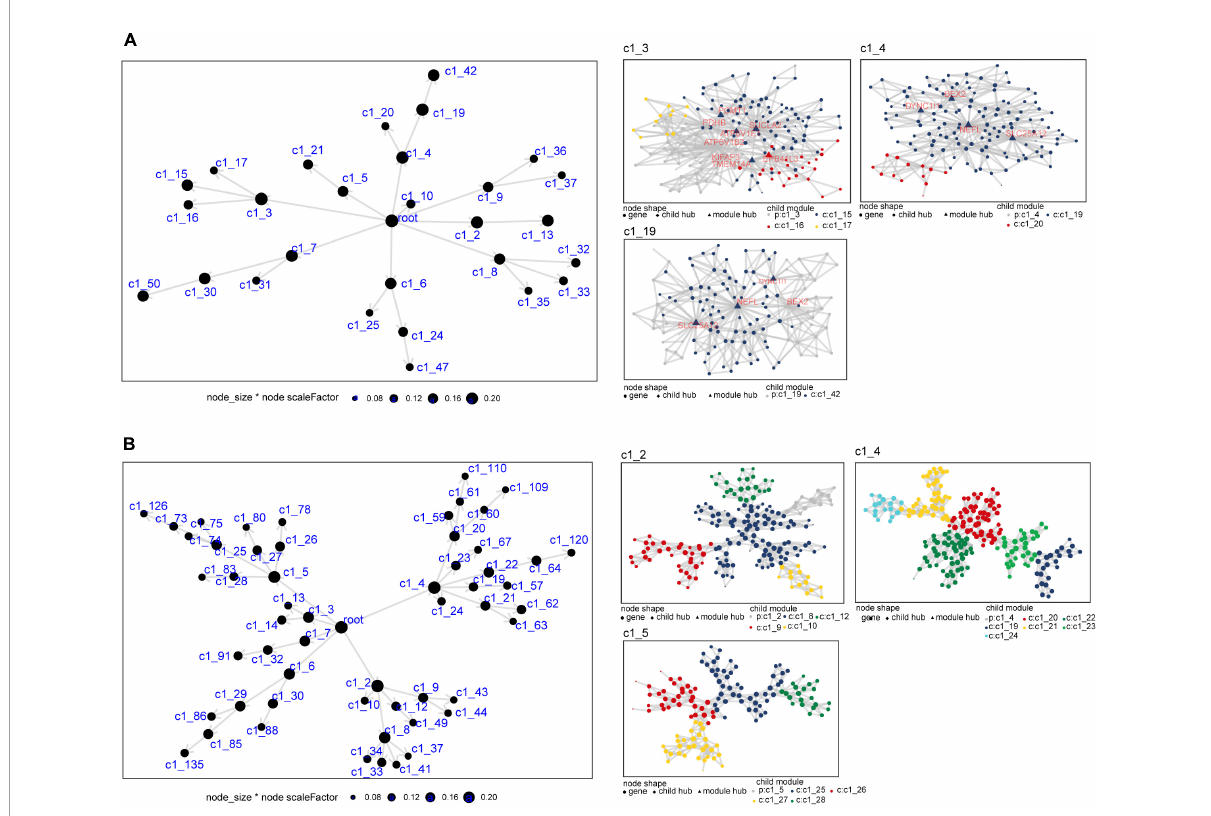
FIGURE4 Multiscale embedded gene co-expression network analysis of common genes in Alzheimer’s disease (AD) and sleep disorder. (A) Differentially expressed genes in the co-expression network for the GSE5281 dataset. The three largest gene modules are shown: C1_3, C1_4, and C1_19. (B) Differentially expressed genes in the co-expression network for the GSE40562 dataset. The three largest gene modules are shown: C1_2, C1_4, and C1_5. Each node represents a module, with the larger nodes indicating a higher number of genes. Each color represents one module, and triangles represent key genes in the